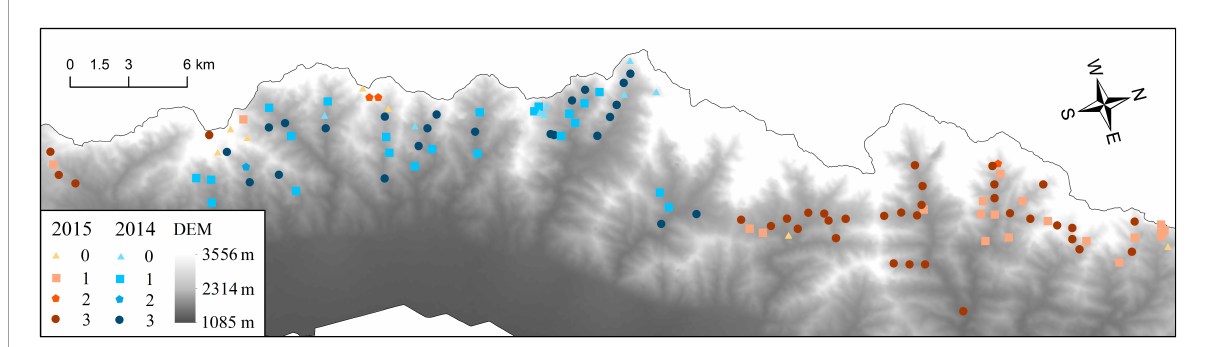
FIGURE2 Spatial overlap of blue sheep and red deer (captured condition of cameras: 0 = no blue sheep or red deer were captured, 1 = only blue sheep were captured, 2 = only red deer were captured, and 3 = both blue sheep and red deer were captured).